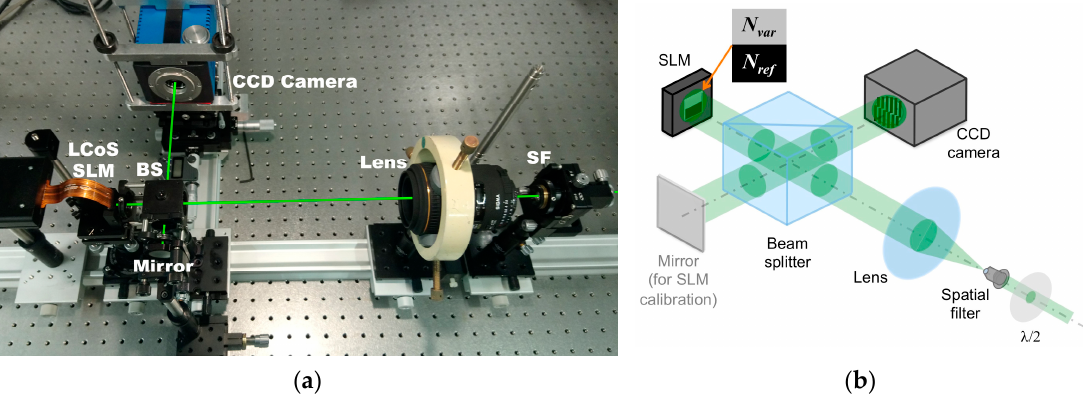
Figure 2. ( a ) Michelson interferometer setup for characterization of the LCoS display (BS stands for beam splitter and SF for spatial filter). The tunable linearly polarized Ar ion-laser and the half-wave plate are not shown. ( b ) Scheme of the Michelson interferometer with a detailed view of the spatial light modulator (SLM) input plane.